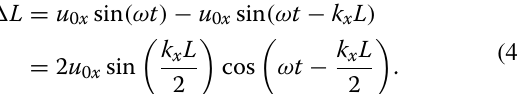
effects of spatial averaging for the long-baseline strain- meter. The noise level rapidly increases below 2 mHz and (BFO) below ~1.5 mHz. According to Zürn et al. (2015),